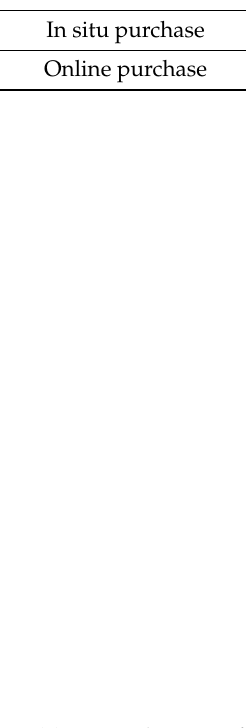
Table 3. Application of the inclusion criteria to select food supplements samples containing folic acid that were subject to chemical analysis (FS1, FS2, FS3, and